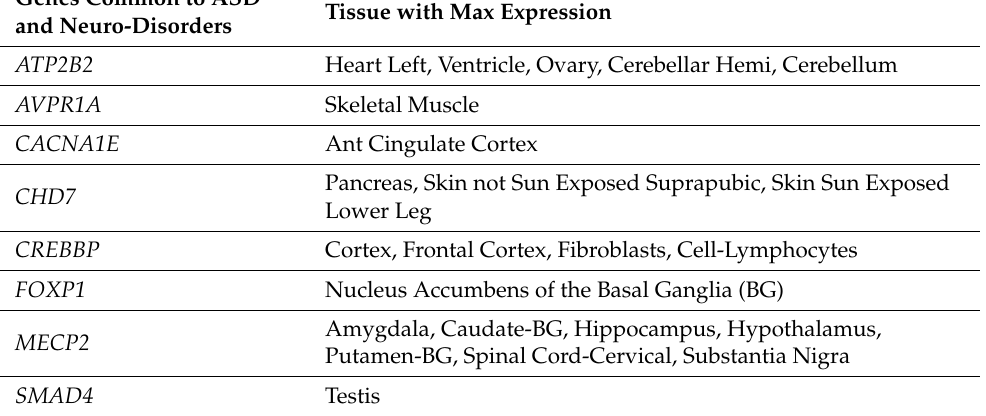
Table 3. Cont. Genes Common to